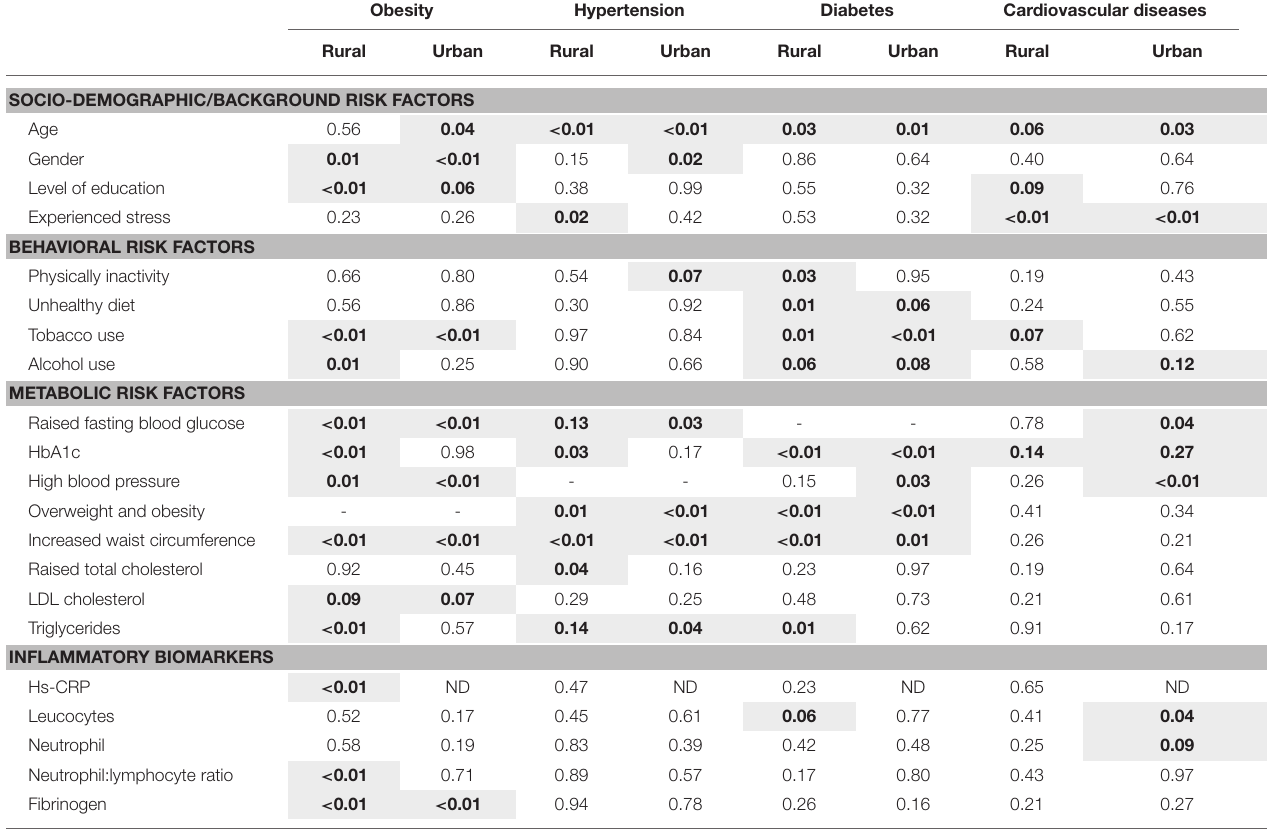
TABLE 4 | Significance of individual risk factors for chronic diseases of lifestyle (CDL). Obesity Hypertension Diabetes Cardiovascular diseases Rural Urban Rural Urban Rural Urban Rural